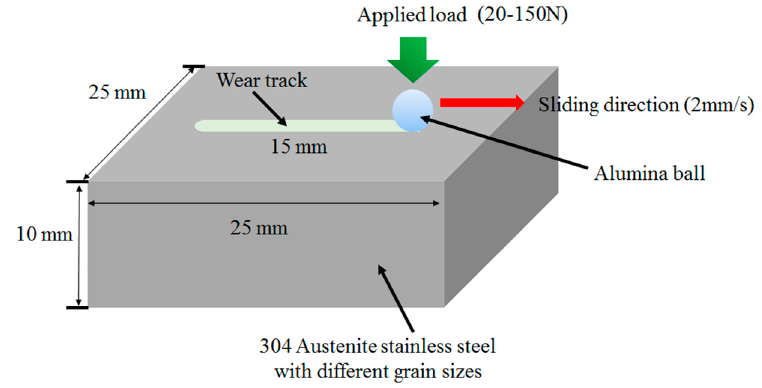
Figure 1. Schematic illustration of the pin-on-plate tribological testing of the 304 austenite stainless